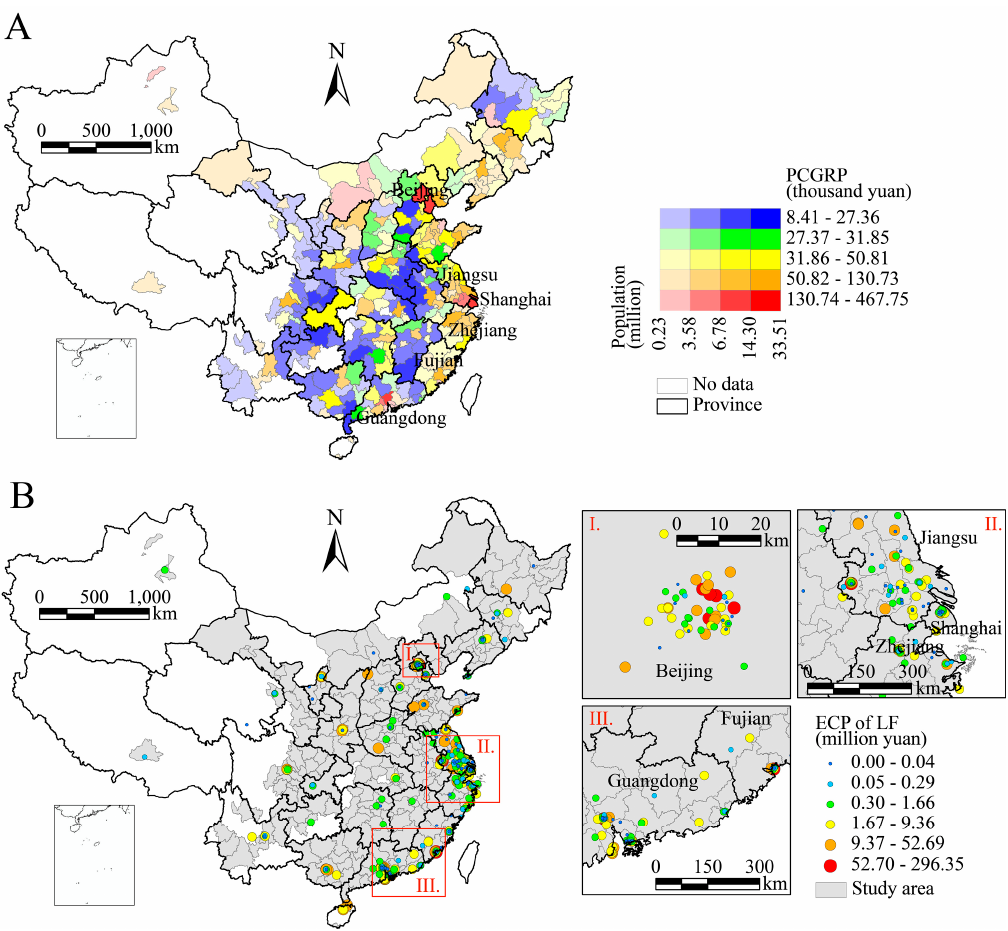
Figure 1. Population and economic distributions in the study area ( A ) and charity expenditures of local foundations ( B ).